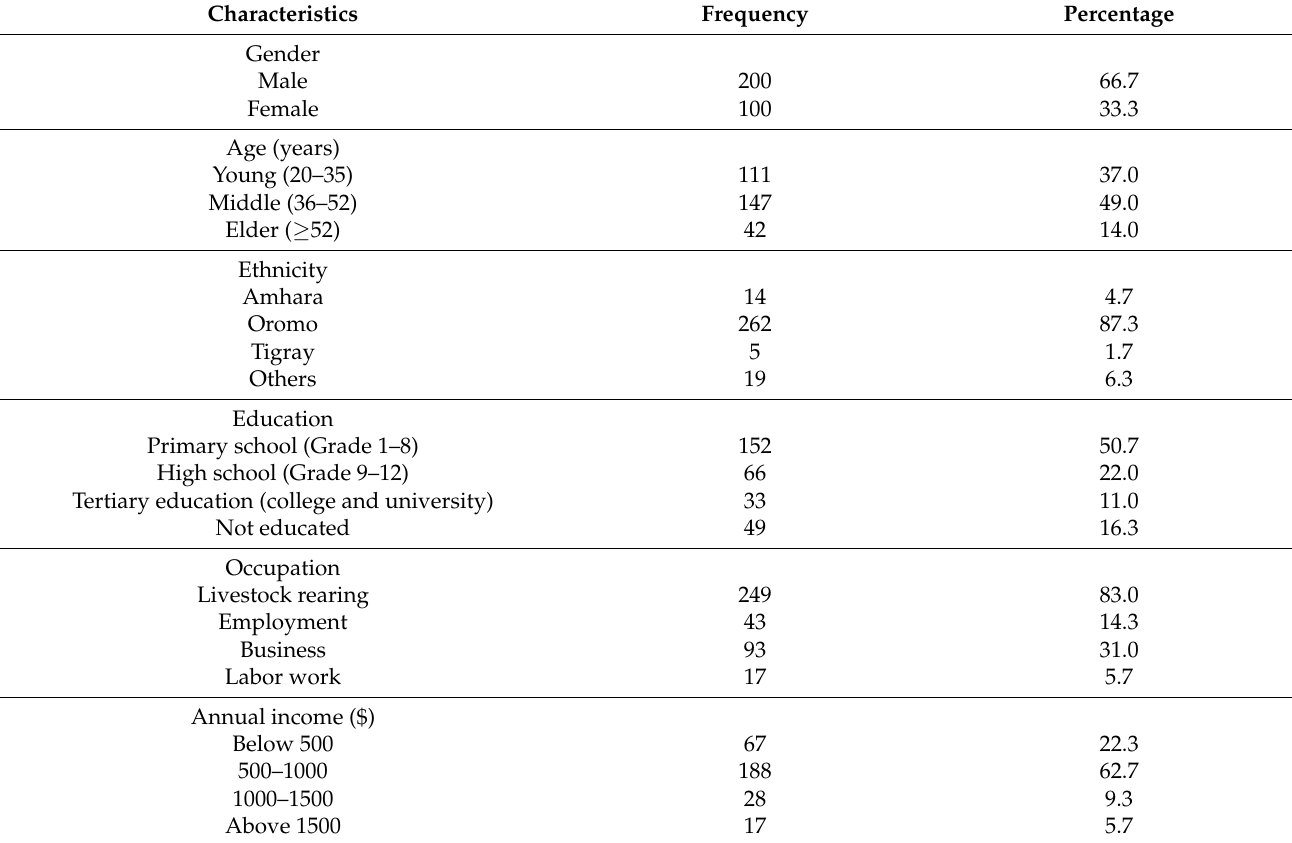
Table 1. Distribution of pastoralists demographic characteristics in Borana rangeland ( n = 300).